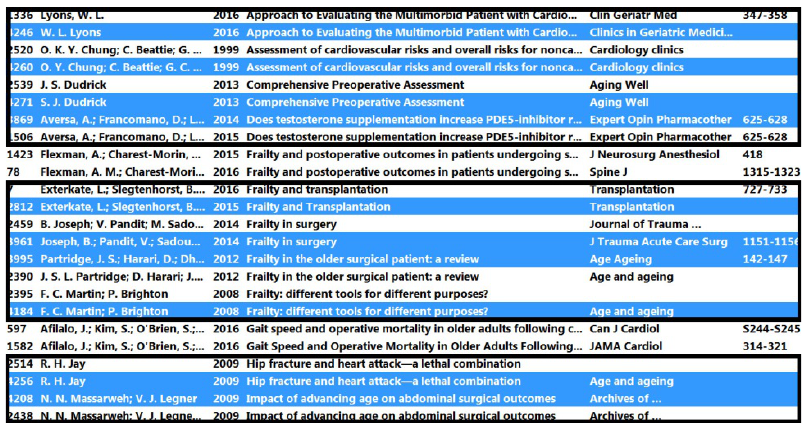
Figure 1 Recognition of pattern change in blue and white references, indicating a duplicate that should not be removed; the references in the black boxes are updates and should all be